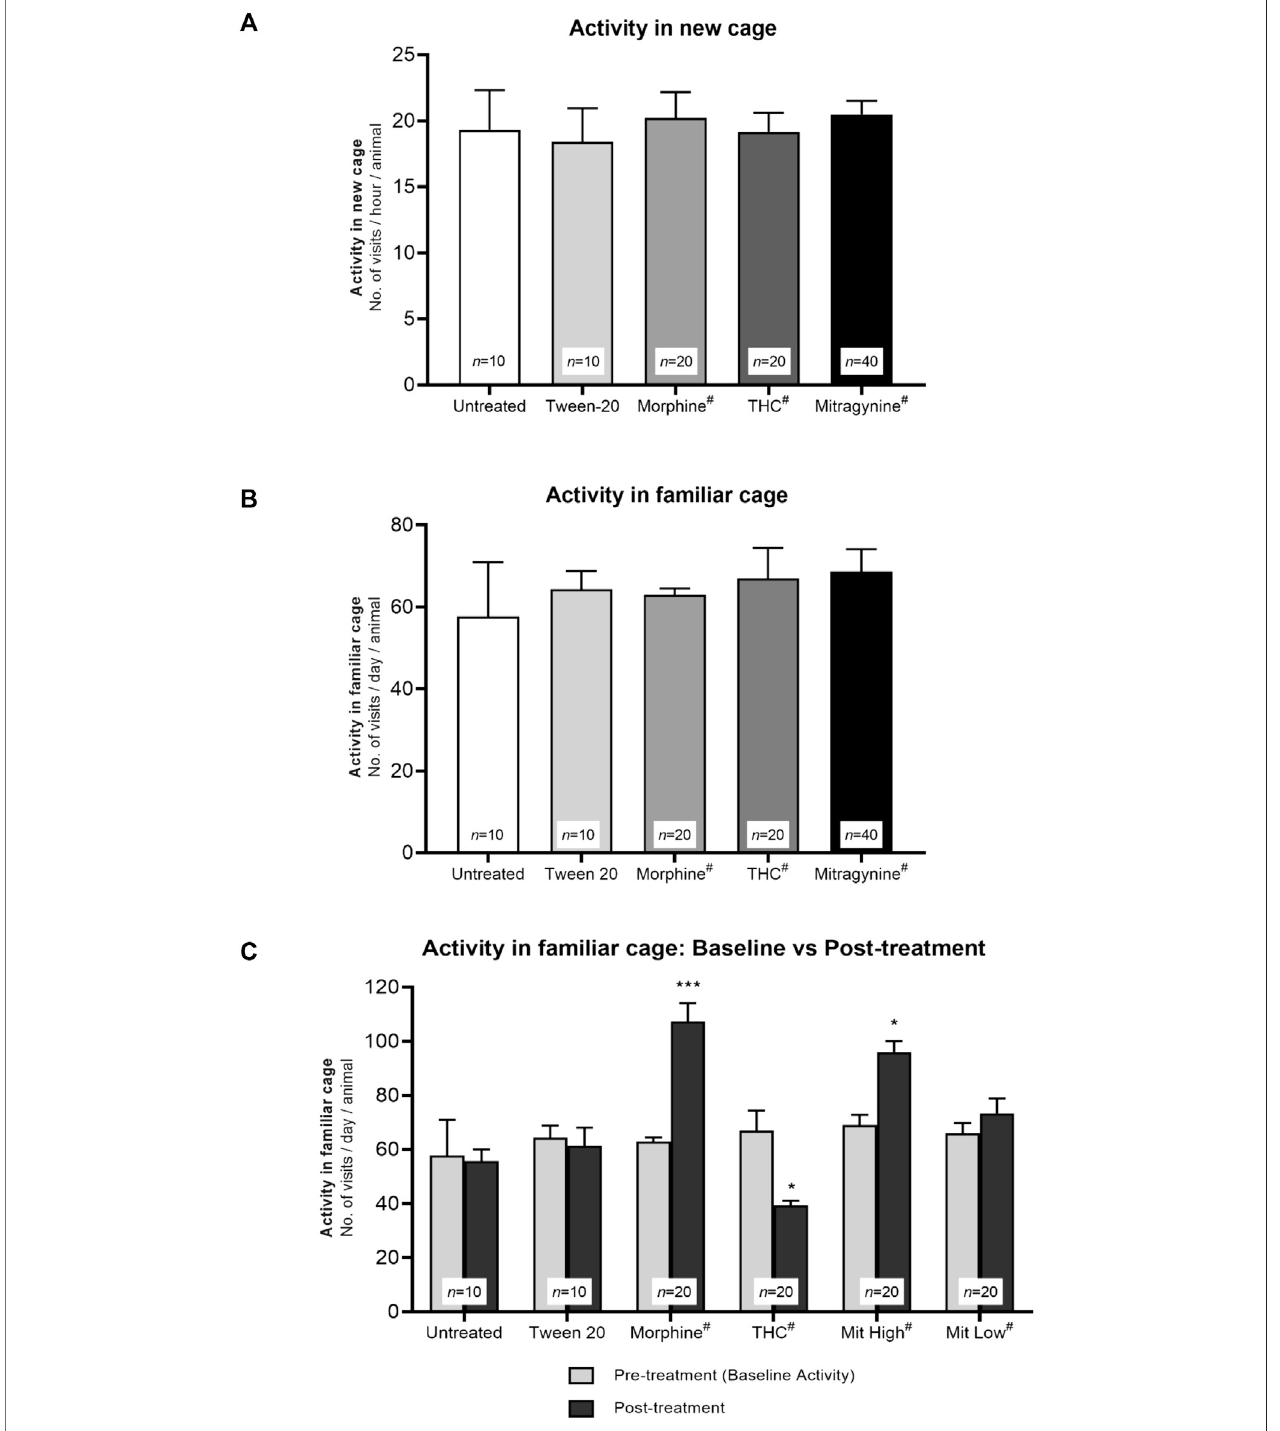
FIGURE2| Effectsofdruginterventiononexploratoryactivities.Baselineexploratoryactivityin (A) noveland (B) familiarenvironment.Themeannumberofvisitsto all corners per test group during the fi rst hour in the novel IntelliCage and 3 consecutive days in the familiar IntelliCage environment throughout the baseline phase. Without any drug intervention, all groups in (A) and (B) showed no signi fi cant differences in novelty-induced exploration and baseline daily activity ( p > 0.05; one-way ANOVA). (C) Effects of drug sensitization to daily activity in the familiar IntelliCage environment. The mean number of visits to all corners during 3 days of baseline phase vs 3 days of sensitization phase (Day 5 – 7). Morphine and high-dose mitragynine – treated mice showed a signi fi cant increment in their general familiar vs baseline activities, in which the increments are comparable (not signi fi cant) between mitragynine vs morphine. By contrast, THC-treated mice showed a signi fi cant decrease in general activity. * p < 0.05 vs baseline; ** p < 0.01 vs baseline (two-way repeated measures ANOVA followed by post-hoc Tukey test). # includes animals from drug only and drug + receptor antagonist groups (i.e., each group n (cid:1) 10).